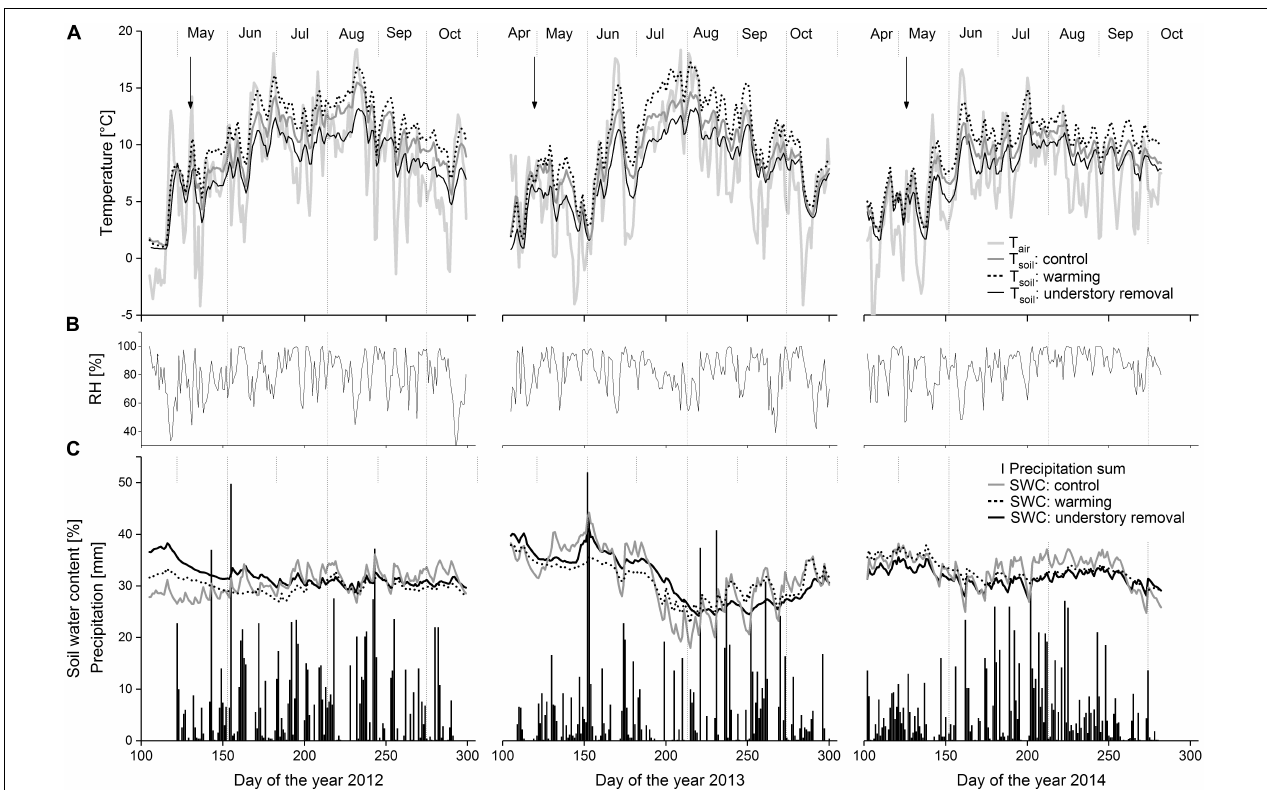
FIGURE 1 | (A) Seasonal course of daily mean air temperature and daily mean soil temperatures in 10 cm soil depth in control, warming and understory removal blocks. (B) Relative air humidity. (C) Daily sum of precipitation and daily mean soil water content in 10 cm soil depth in control, warming and understory removal blocks from April to October 2012, 2013, and 2014. Arrows indicate roof closure.